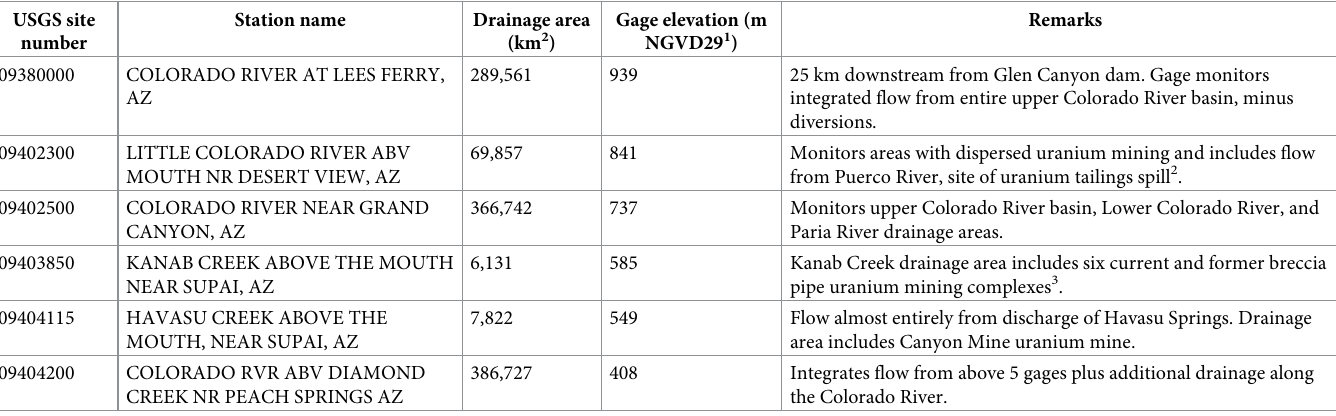
Table 1. Details of monitoring sites in Grand Canyon used for this